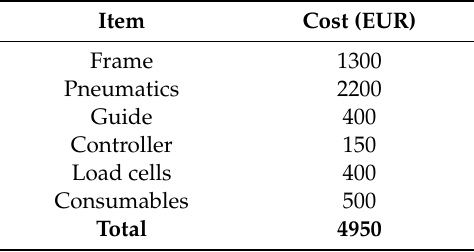
Table 1. Approximate component